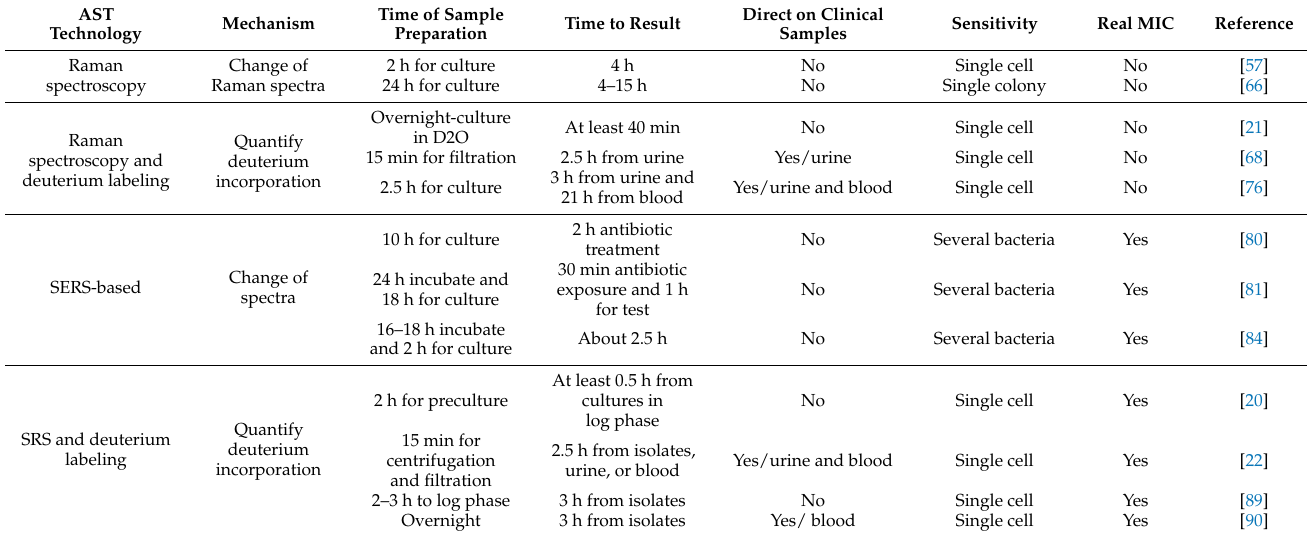
Table 2. Comparison of Raman-based AST